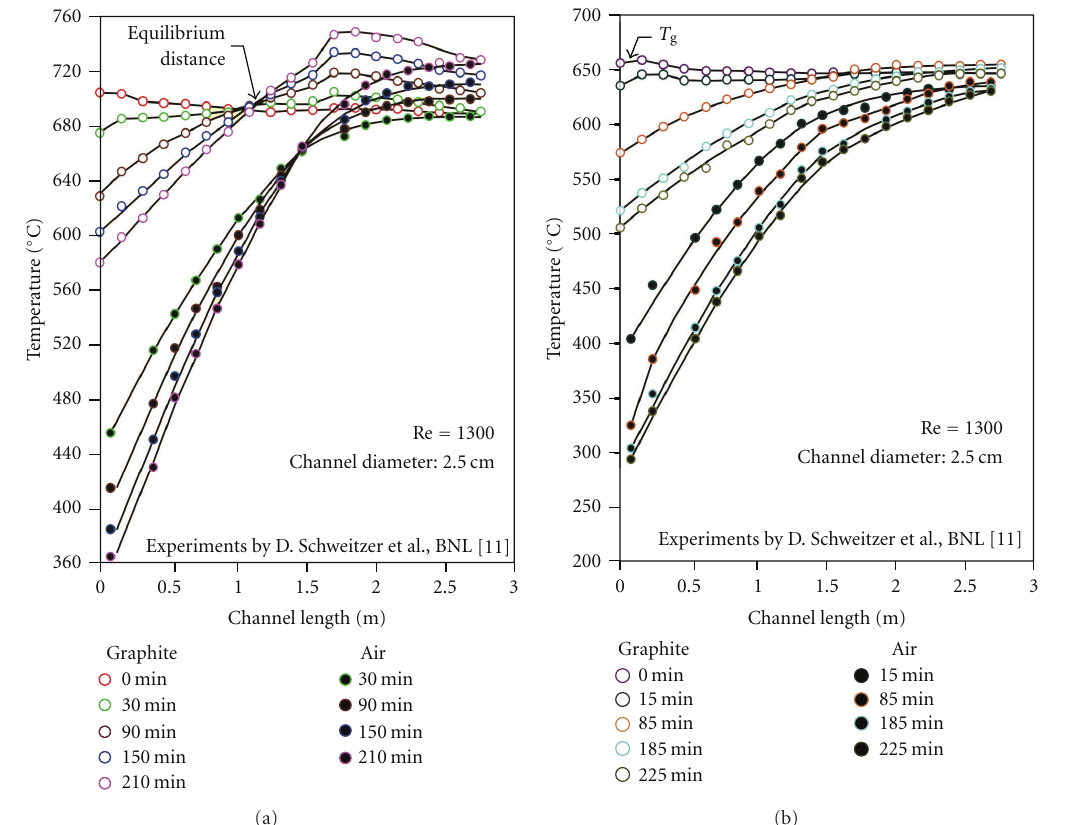
Figure 4: Time-dependent temperature development in a graphite channel with air flow (initial graphite temperatures: (a) = 700 ◦ C, (b) = 650 ◦ C).